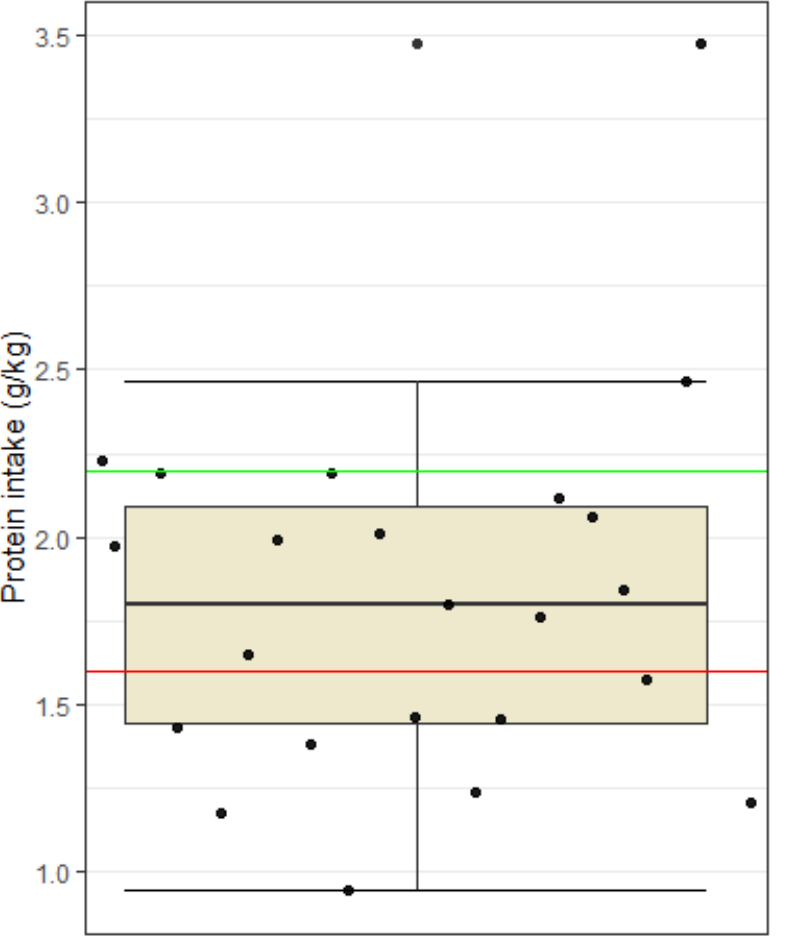
Figure 3. Protein intake among football players. Dots represent individual participants ( n = 23). The red line indicates the lower limit of the recommended intake (1.6 g/kg BW) and the green line the upper limit of the recommendations (2.2 g/kg BW).